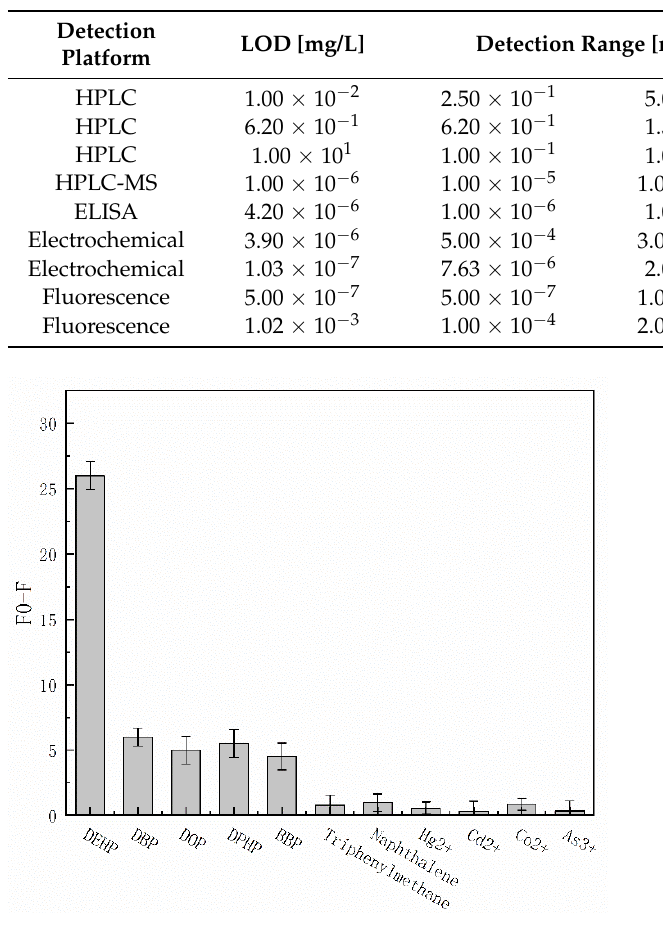
Figure 4. Fluorescence change curve of the selectivity analysis. The dose of disruptors was 20 µg/L. An error bar represents the error for three independent experiments.